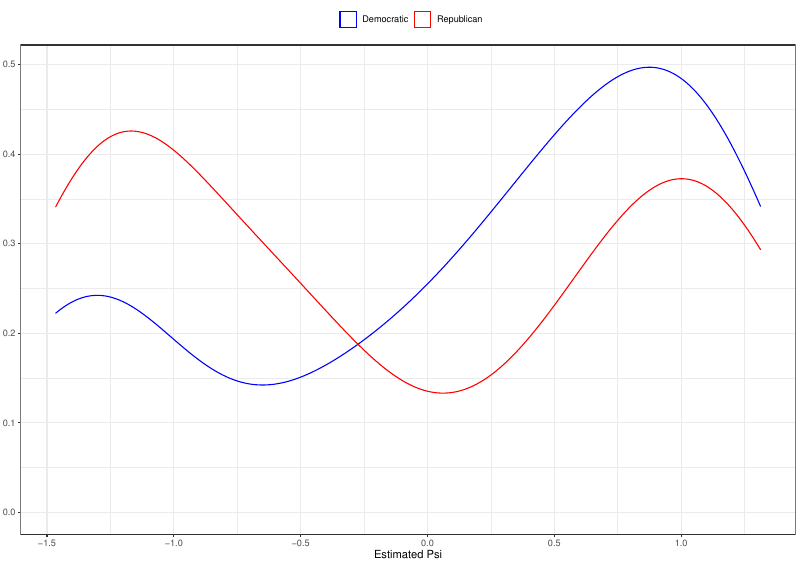
Figure 3. Wordfish scores for Republican presidents (blue line is the smoothed Loess curve).